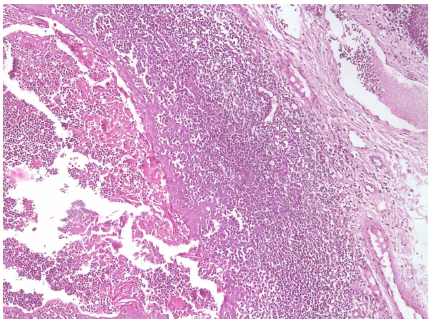
Figure 2: Photomicrograph of lymphoepithelial cyst showing cystic cavity lined by keratinized epithelium and filled with desquamated keratin intermixed with lymphocytes (H&E ×